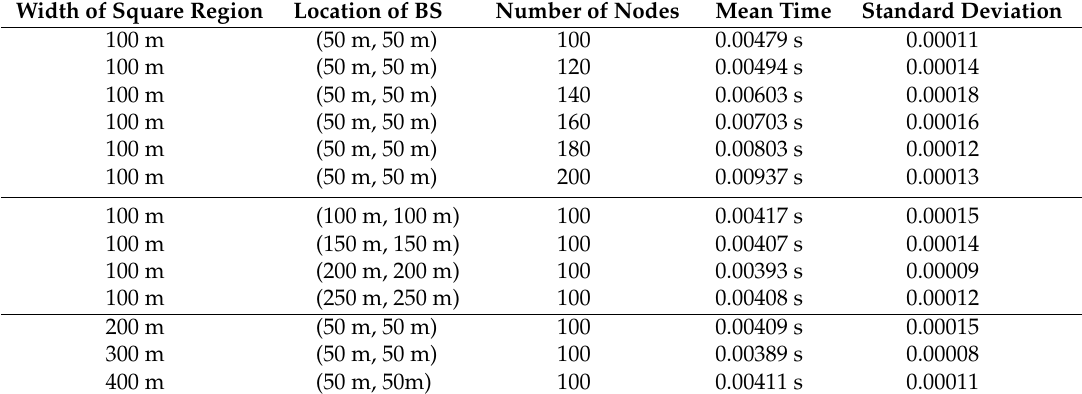
Table 2. Statistical Time of Computational Complexity for Various Deployment Scenarios.